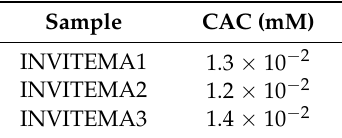
Table 3. Found critical aggregation concentration (CAC) values, by pyrene method, for INVITEMA bioconjugates.